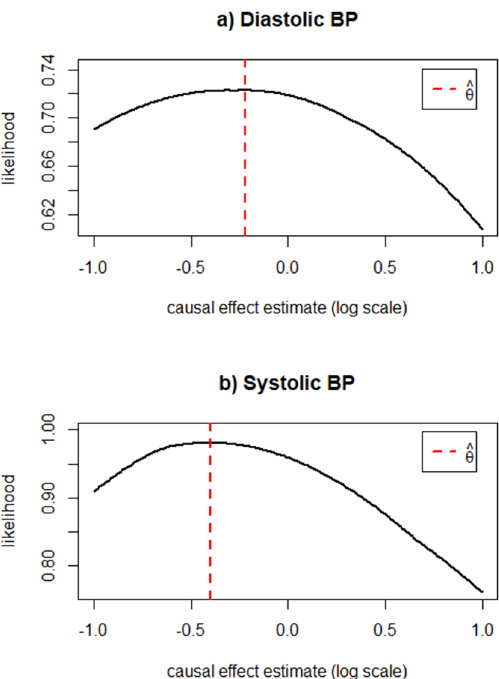
Figure 3. MRMix estimation performance—mixed ethnicity sample. These two plots display the estimated θ ) during maximum likelihood estimation for diastolic and systolic blood pressure by causal effect (theta, MRMix in the multi-ethnicity sample. A clear, sharp peak indicates stable performance in the estimation of (cid:31) theta. The dotted red lines indicate the ML estimates of theta ( θ ) reported in the Results section, respectively for each